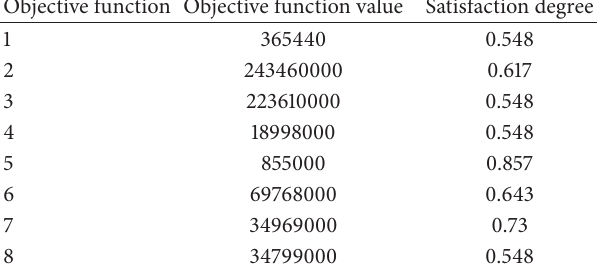
Table 26: Obtained objective function values and the satisfaction